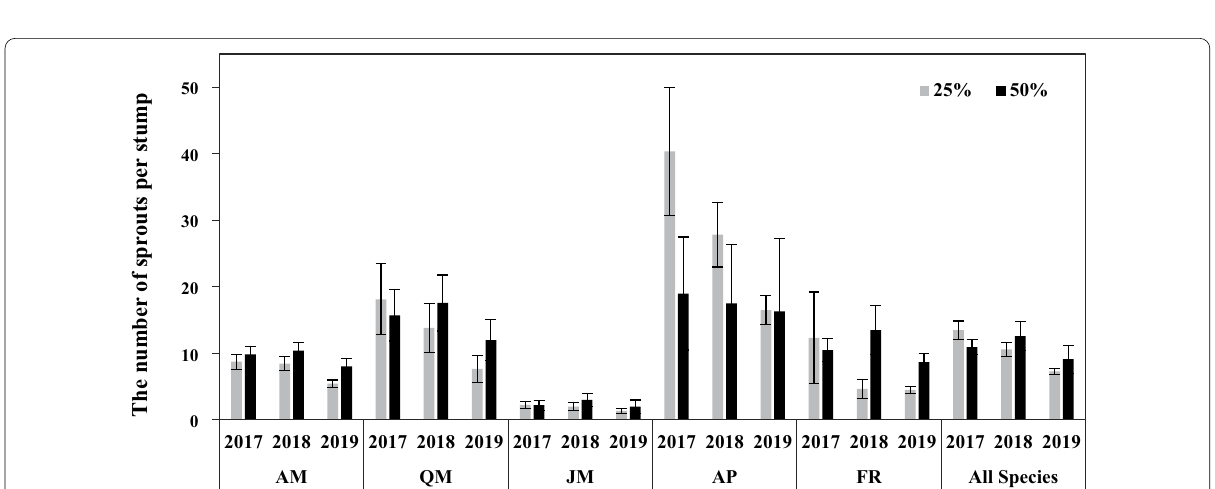
Fig. 6 Number of sprouts per stump for main species (AM, QM, JM, AP, and FR) and all woody species for the 25% (25% of the basal area removal) and 50% (50% of the basal area removal) logging intensities in August 2017, 2018, and 2019. The values are presented as the means AM Acer mono , QM Quercus mongolica , JM Juglans mandshurica , AP Acer pseudosieboldianum , and FR = = = =